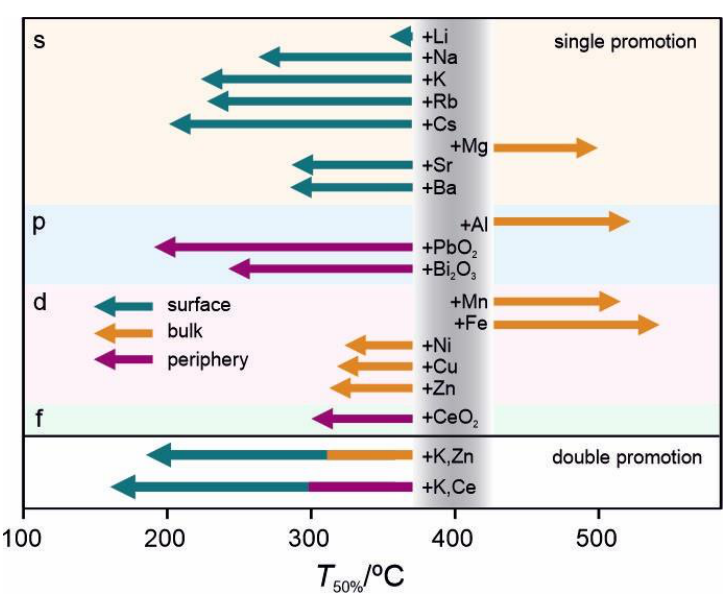
Figure 8. The deN 2 O performance of Co 3 O 4 -doped phases compared by T 50% parameter (catalytic test conditions: a mixture of gases 5% N 2 O / He, GHSV = 7000 h − 1 ).